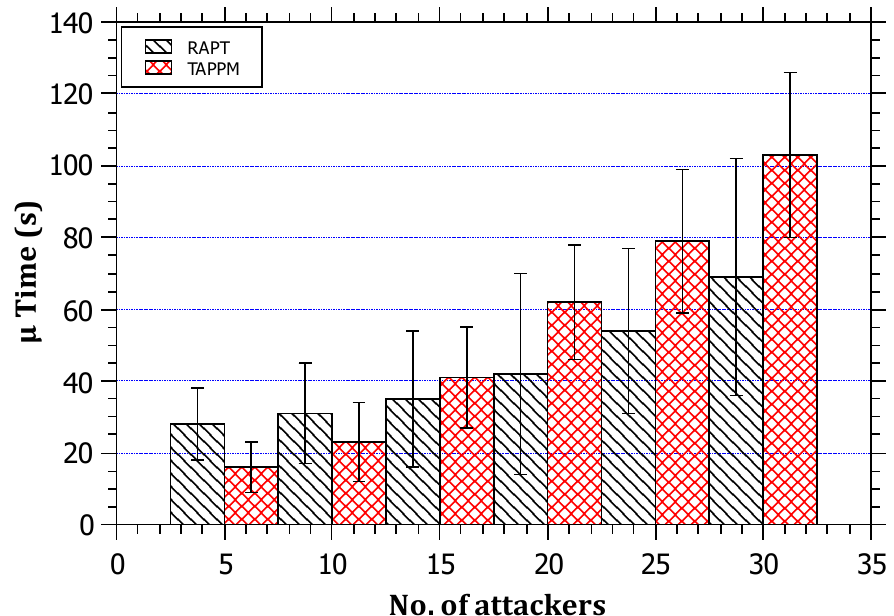
Figure 12. The relationship between the distance of the attack and its detection